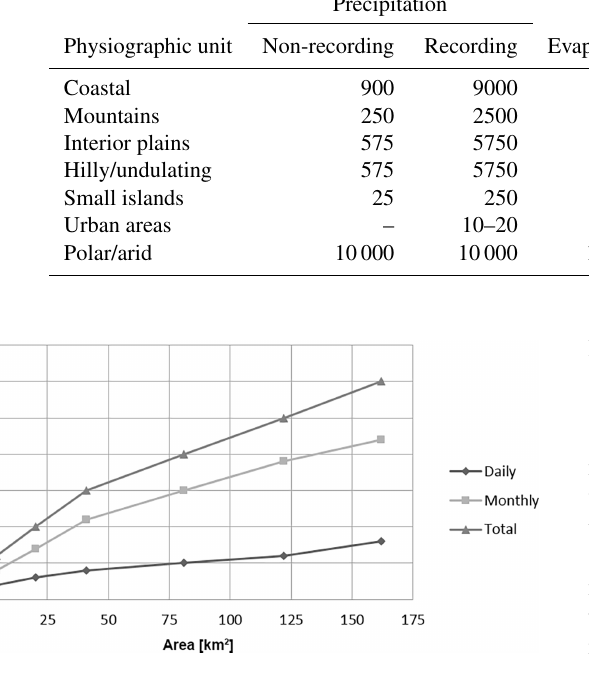
Figure 5. Minimum number of rain gauges required in reservoired moorland areas – adapted from Bleasdale